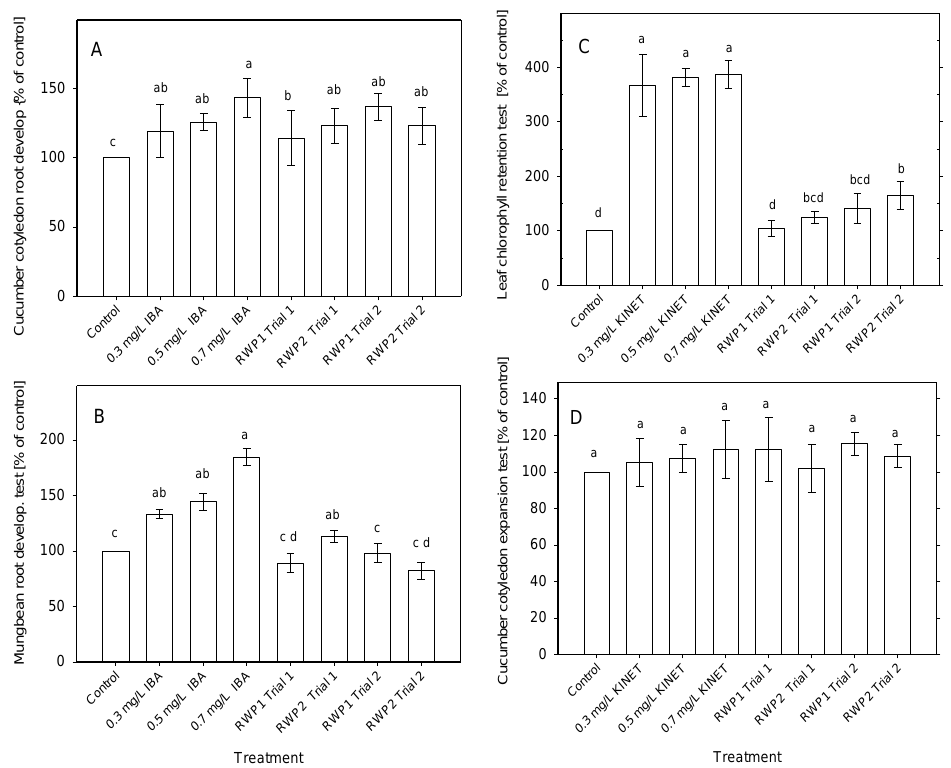
Figure 8. The auxin activity of microalgae was detected using the cucumber cotyledon root development test ( A ) or by mung bean root development test ( B ). Indol − 3-butyric acid (IBA) was used as the standard. The cytokinin-like activity was detected using the leaf Chl retention test ( C ), and the cucumber cotyledon expansion test ( D ). Kinetin was used as the standard (positive control). Water extracts of freeze-dried microalgae samples (2 mg DW L − 1 ) were taken from the bioreactors RWP1 and RWP2, respectively on Days 1 and 3 during outdoor trials in M é rida. The results are presented as mean ± SD ( n = 18). Different letters indicate significant differences analyzed by one-way analysis of variance and Duncan’s multiple range test ( p <